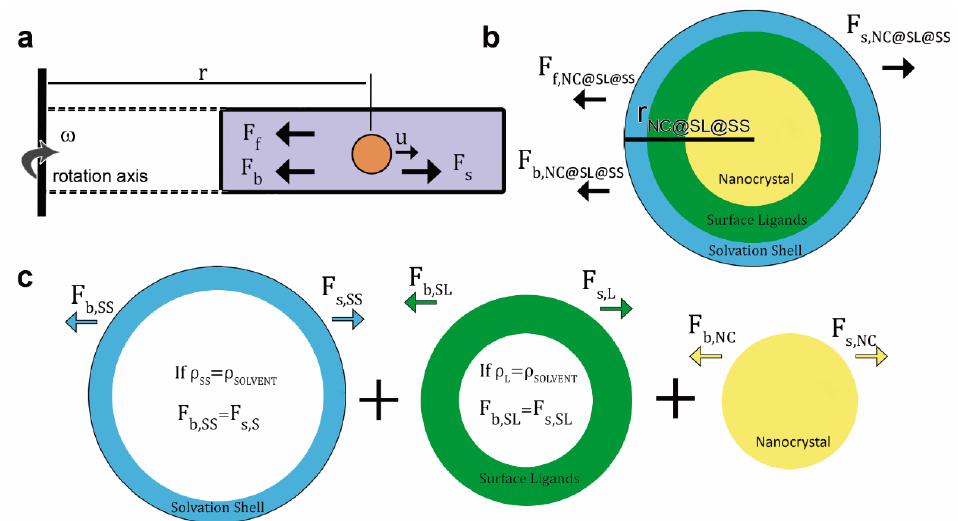
Figure 1. ( a ) Schematic of the three different forces acting on colloids during sedimentation under a centrifugal field. ( b ) Schematic of the model typically used to describe NCs colloidally stabilized by SLs and covered by a SS, and often applied to the AUC data analysis (r NC@SL@SS = radius of the NC@SL@SS). ( c ) Schematic of the different centrifugal (F s ) and buoyant (F b ) force contributions arising from SSs (F s,SS and F b,SS ), SLs (F s,SL and F b,SL ), and NCs (F s,NC and F b,NC ). When the density of SLs ( 𝜌 SL ) and SS ( 𝜌 SS ) equals that of the solvent ( 𝜌 = 𝜌 SS = 𝜌 SL ), they do not float or sediment under an applied centrifugal field, as the centrifugal and buoyant forces reach equilibrium and cancel out each other: F s,SL = F b,SL and F s,SS = F b,SS .